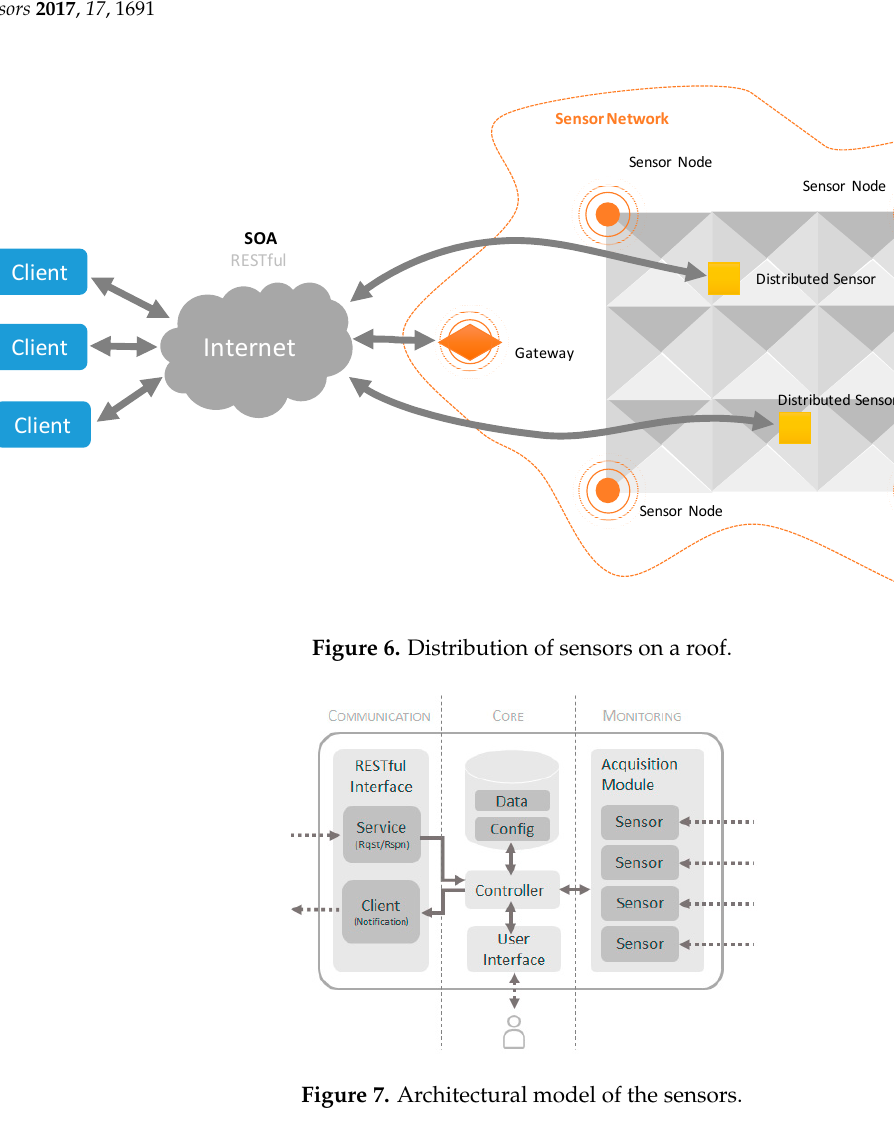
Figure 7. Architectural model of the sensors.